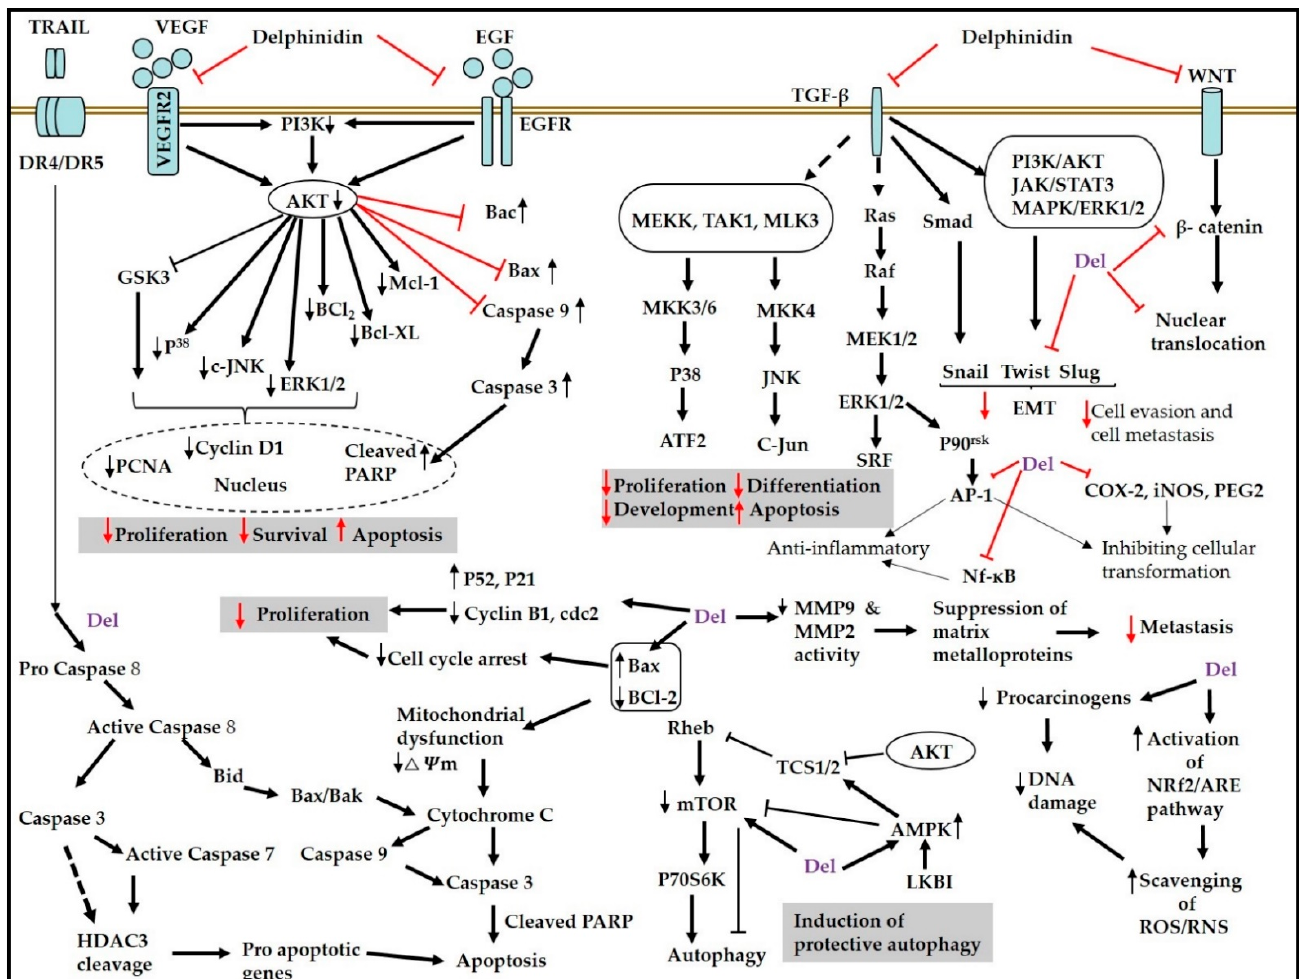
Figure 2. Plausible chemotherapeutic and chemopreventive working mechanisms of delphinidin and its glycosides [14,20– Figure 2. 22,24–26,28–32].